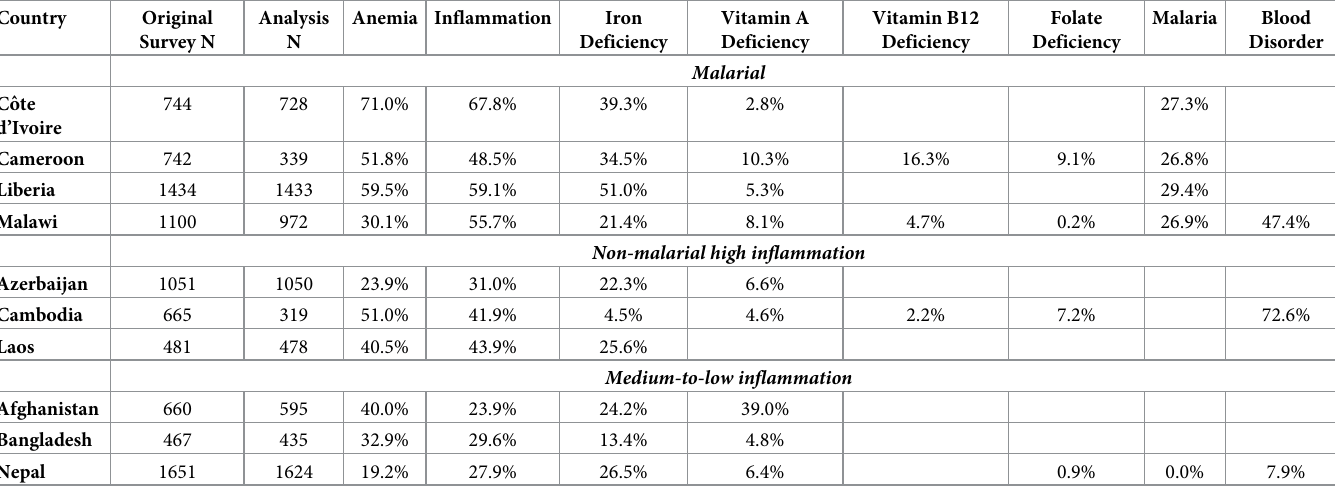
Anemia defined as hemoglobin adjusted for altitude < 11.0 g/dL, inflammation defined as either CRP > 5 mg/L or AGP > 1 g/dL, iron deficiency defined as inflammation-adjusted ferritin < 12 μ g/L, vitamin A deficiency defined as inflammation-adjusted retinol binding protein or retinol < 0.7 μ mol/L, folate deficiency: red